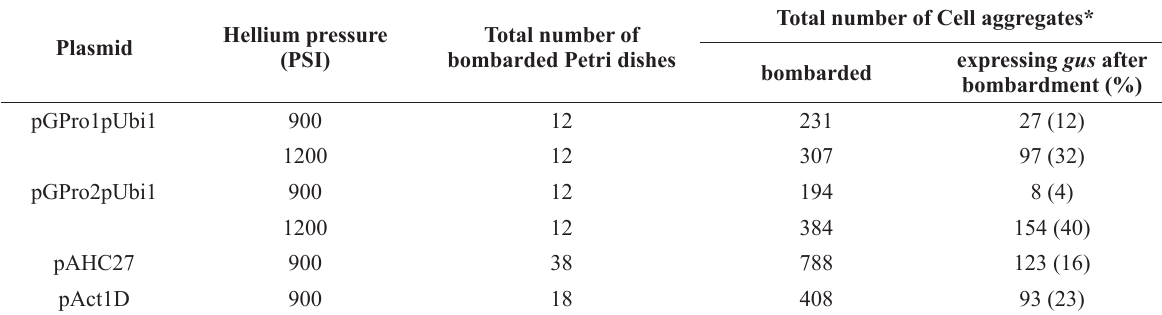
Expression of gus in Brachiaria brizantha cell suspensions bombarded with different plasmids using different helium